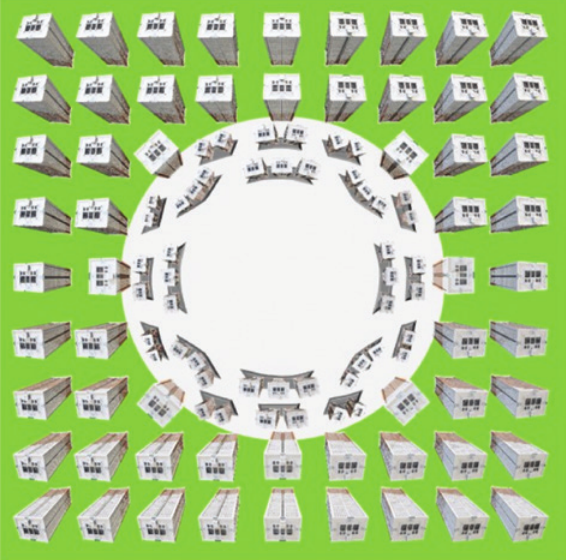
Figure 6: Top view of a megastructure made of a set of above- surface bending resonators (cf. Figure